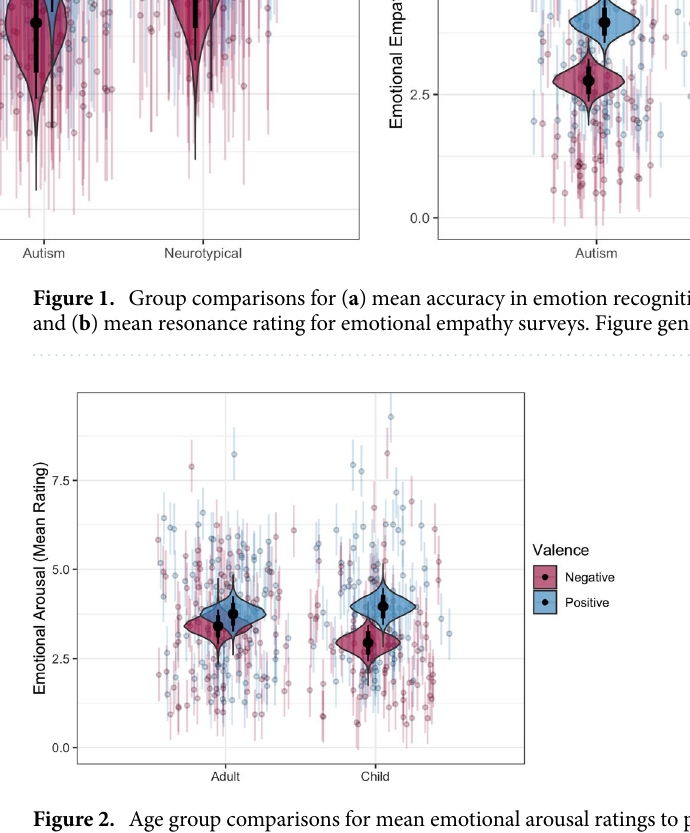
Figure 2. Age group comparisons for mean emotional arousal ratings to positive and negative emotionally charged facial expressions. Figure generated in R 41